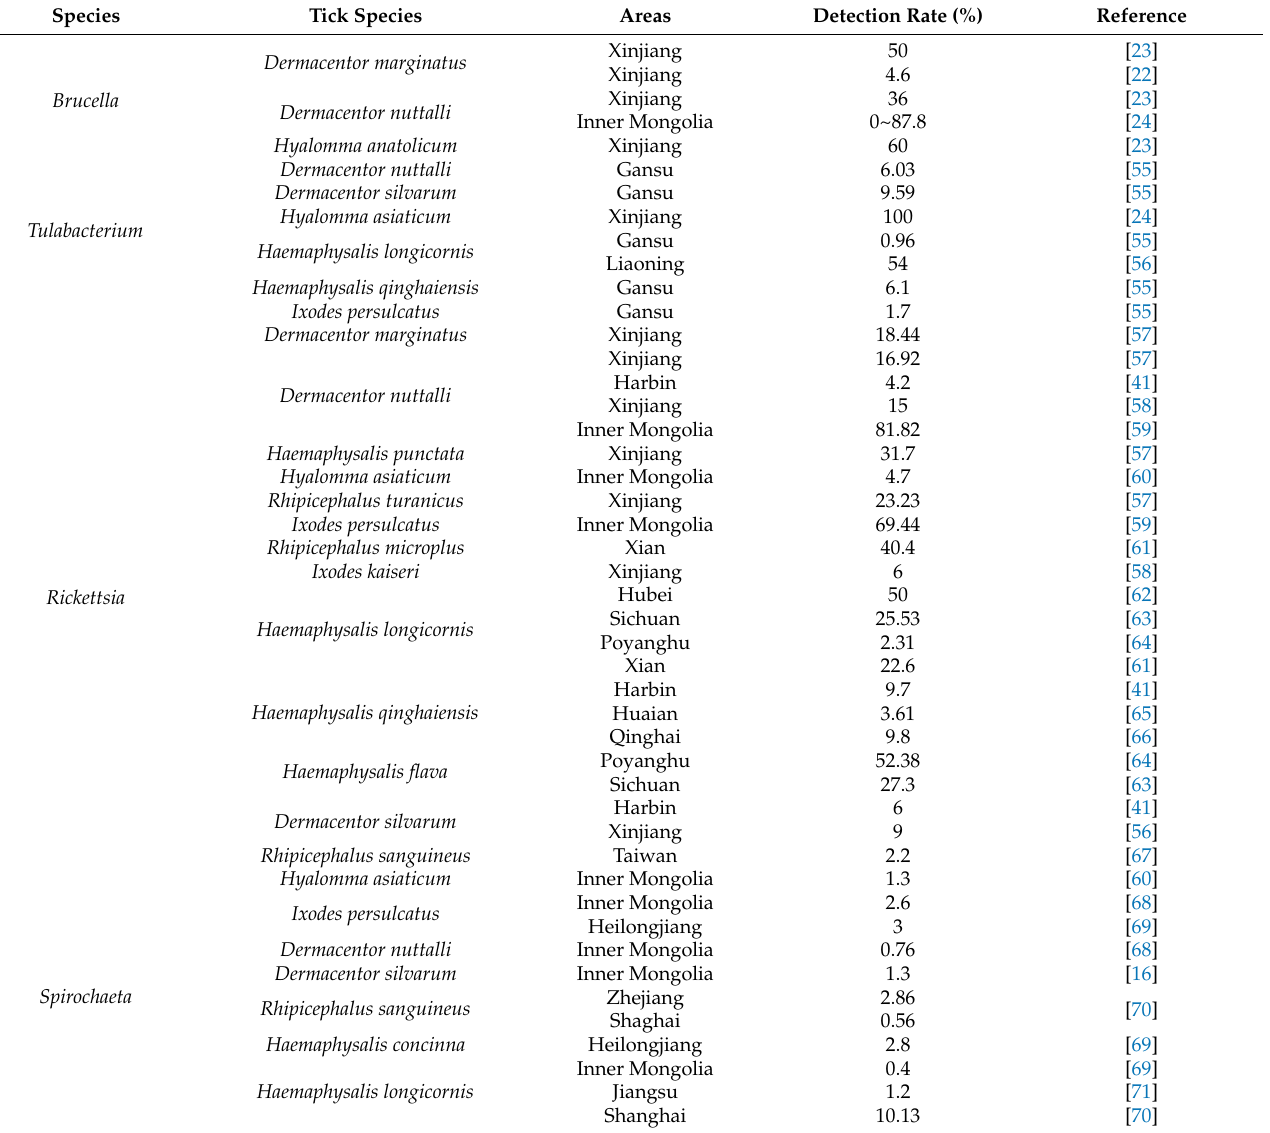
Table 1. Detection rate of tick-borne